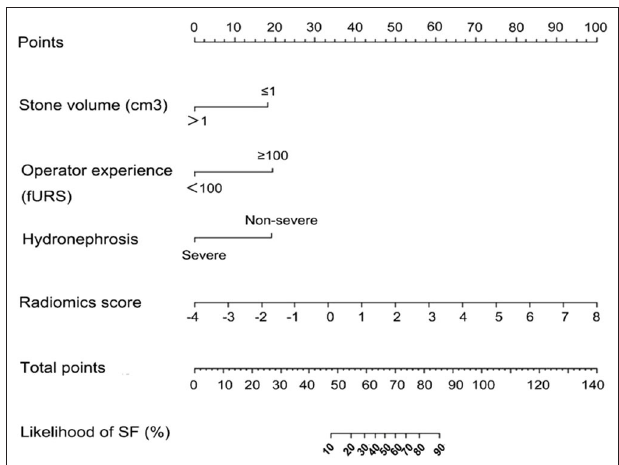
FIGURE 2 | Established clinical–radiomics nomogram model. The clinical–radiomics nomogram was generated in the primary cohort, with the radiomics signature, stone volume, operator experience, and hydronephrosis level